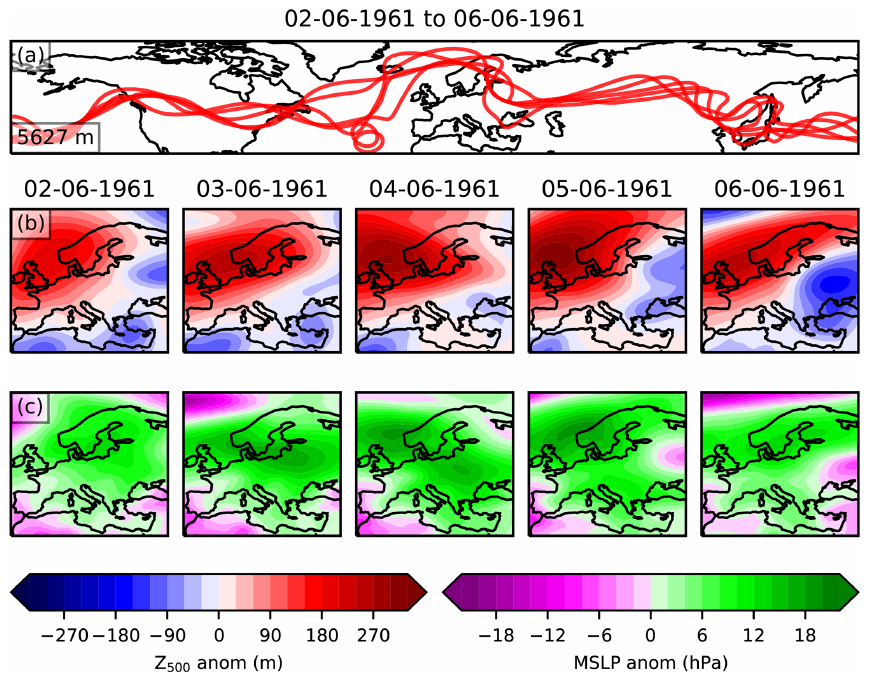
Figure A1. The information used to classify blocks in the UKESM GTD. Panel (a) shows the daily Z 500 contour for the averaged value across 30–70 ◦ N, indicated in the bottom left of the panel. Panels (b) and (c) show the Z 500 time detrended anomaly and MSLP anomaly for each